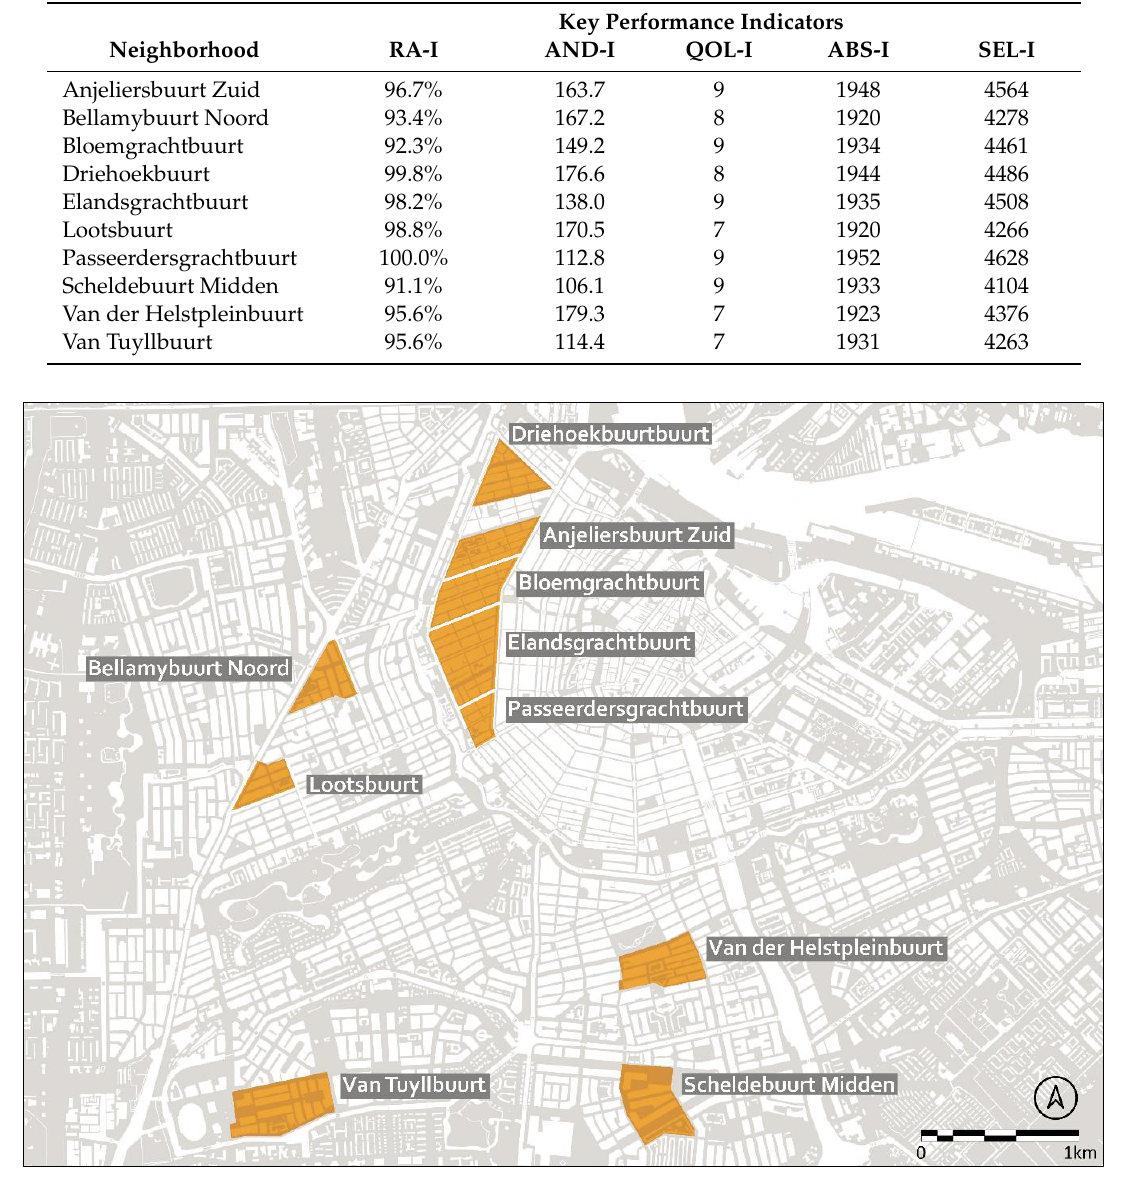
Figure 25. Position of the ten selected “template” neighborhoods in Amsterdam. Table 7. (Indoor) living spaces of the ten “template” neighborhoods.